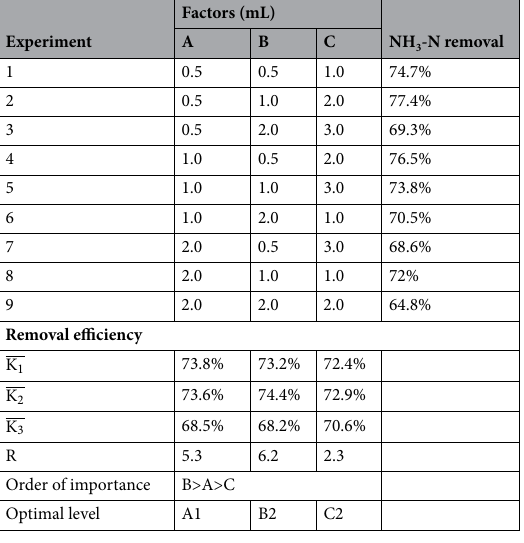
Table 3. Analysis and results of orthogonal experimental design for bacteria/microalgae